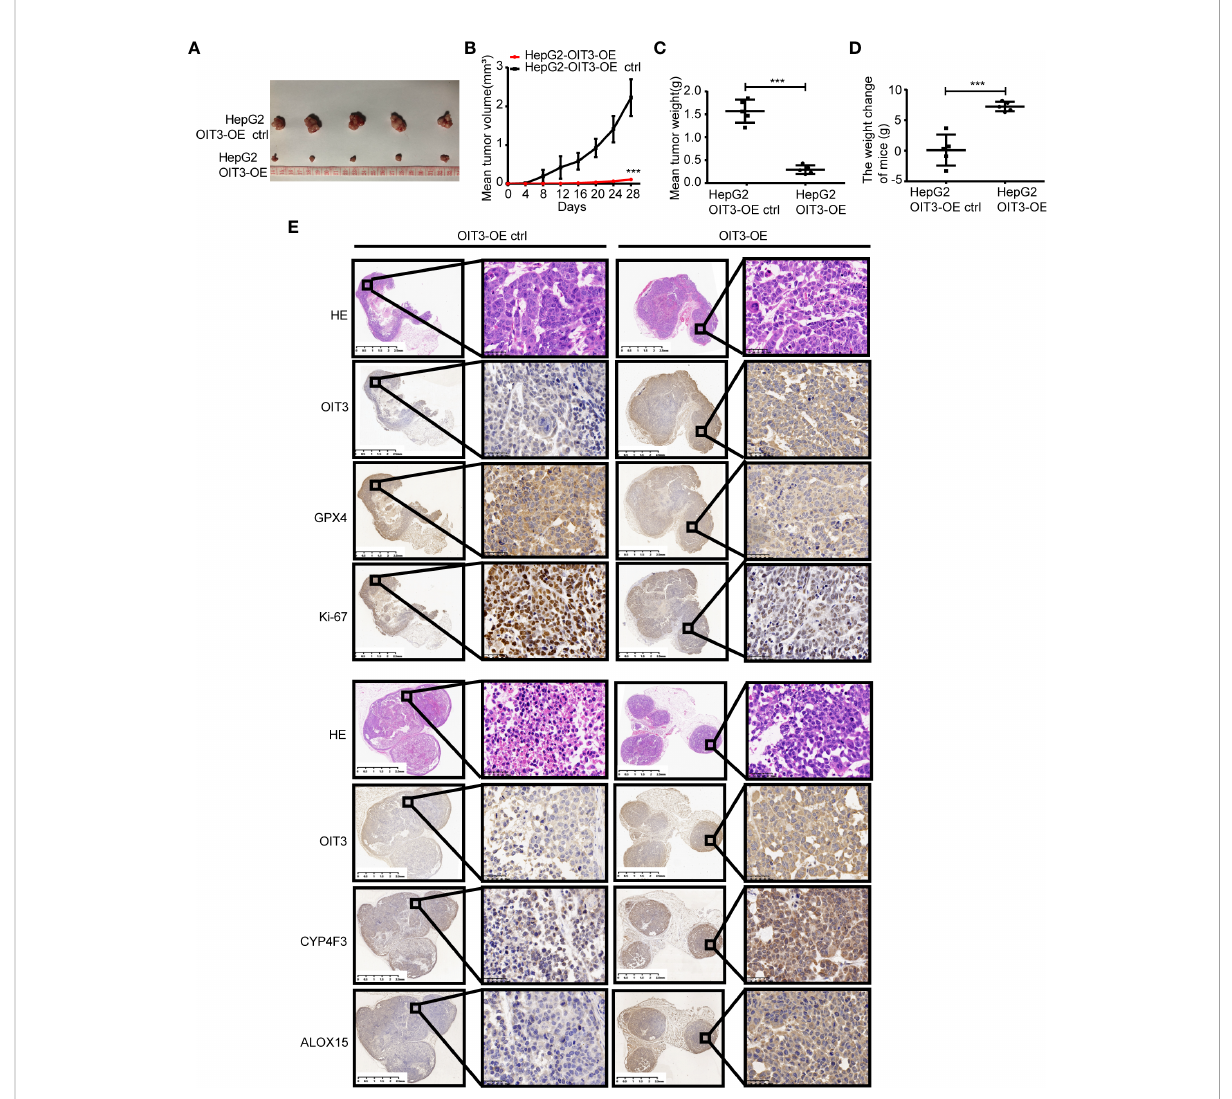
FIGURE 9 OIT3 promoted the ferroptosis of HCC cells in vivo . (A – C) The volume and weight of HCC tumors with different levels of OIT3 expression (n = 5, ***P < 0.001 ). (D) The weight change of mice in different groups.(n = 5, ***P < 0.001 ). (E) Compared to the control group, lower levels of GPX4 and Ki-67 with higher levels of ALOX15 and CYP4F3 could be observed in the mice from the OIT3 upregulating group. OIT3-OE, OIT3- overexpressed lentivirus vector; OIT3-OE ctrl, OIT3-overexpressed lentivirus vector